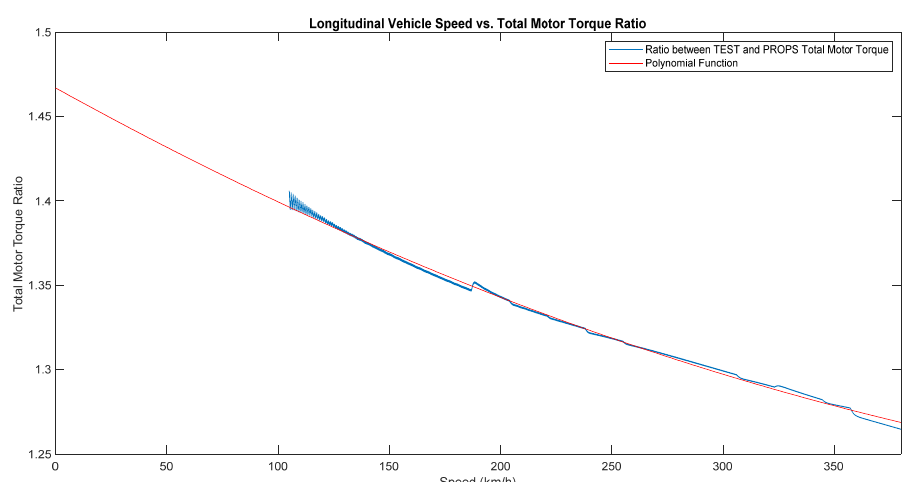
Figure 20. Second degree polynomial (in red) that approximate the ratio between the TEST and PROPS torques (in blue).